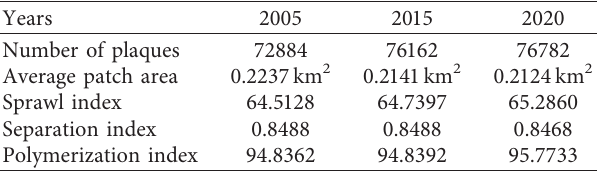
Table 4: Landscape index of ecological city landscape